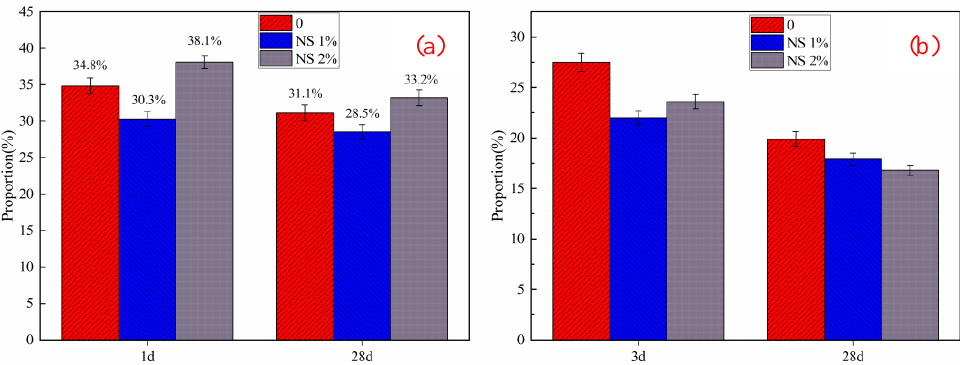
Figure 11. Porosity of cement mortar: ( a ) HBSAC cement; ( b ) P·O 42.5 cement.